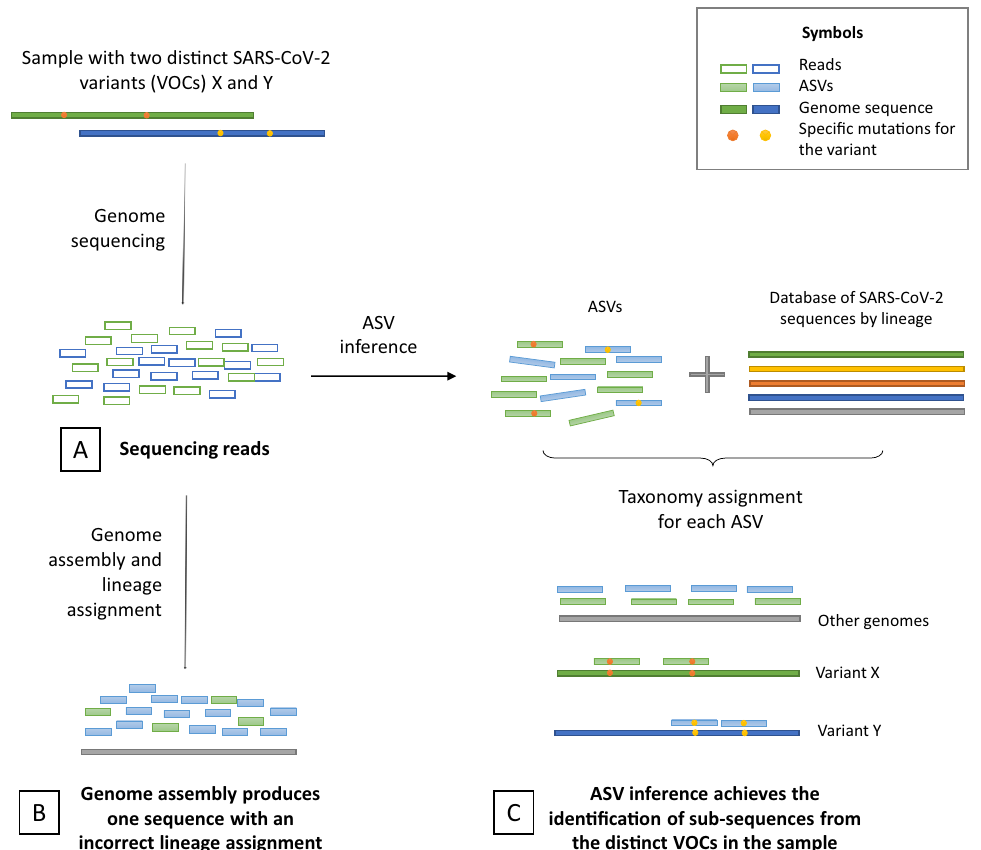
Figure 1. Conceptual design of the approach to identify co-infection by SARS-CoV-2 VOCs. Samples with two distinct VOCs (X and Y) of the SARS-CoV-2 virus are sequenced ( A ). Using a strategy for the whole-genome assembly, a single and misclassified sequence is obtained ( B ). In contrast, the correct identification of the two VOCs is achieved when an ASV inference is implemented, with the use of a custom database of SARS-CoV-2 for the taxonomy assignment. In this process, specific ASV are recognized for the VOCs, while shared ASVs among all the genomes are assigned to other